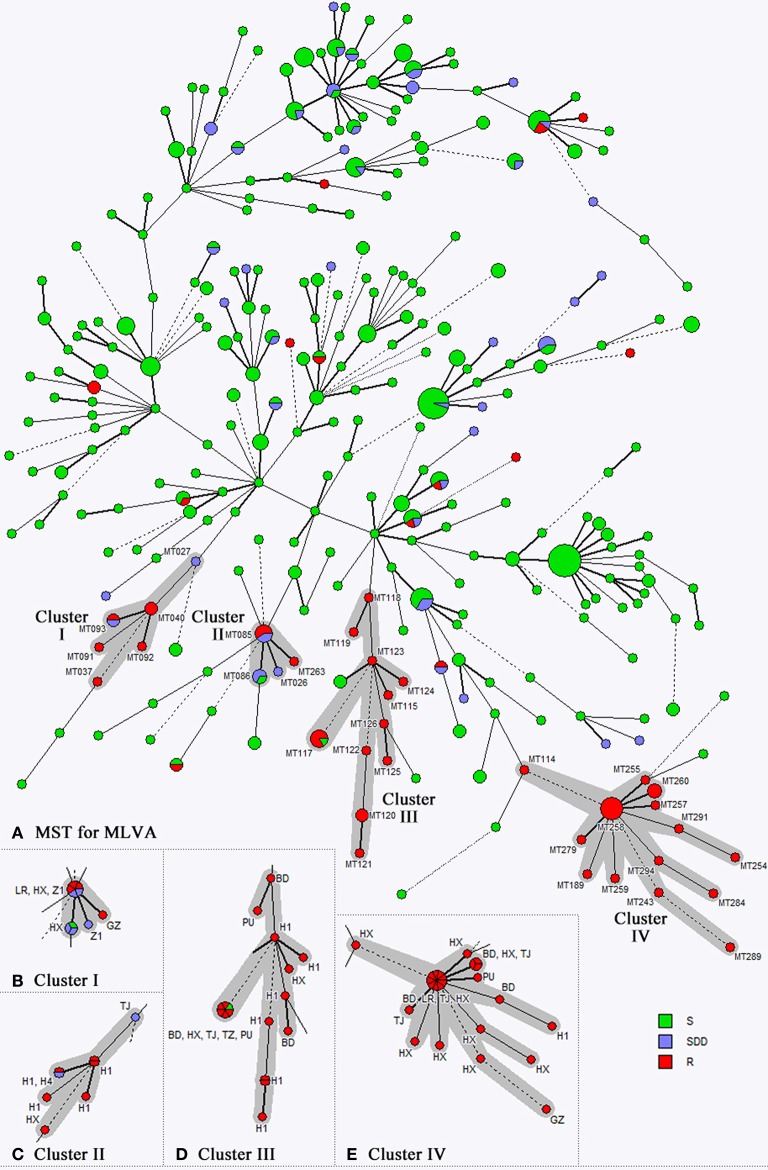
The minimum spanning tree (MST) draw by three-locus microsatellite genotyping results of 507 C. tropicalis isolates. Panel (A) and four genotype clusters associated with fluconazole non-susceptible phenotypes (B–E). Each circle corresponds to a microsatellite genotype, and the size of circle represents number of isolates for each genotype. Different colors in the circle represents different fluconazole susceptibility categories. The lines between circles indicate the similarity between profiles.